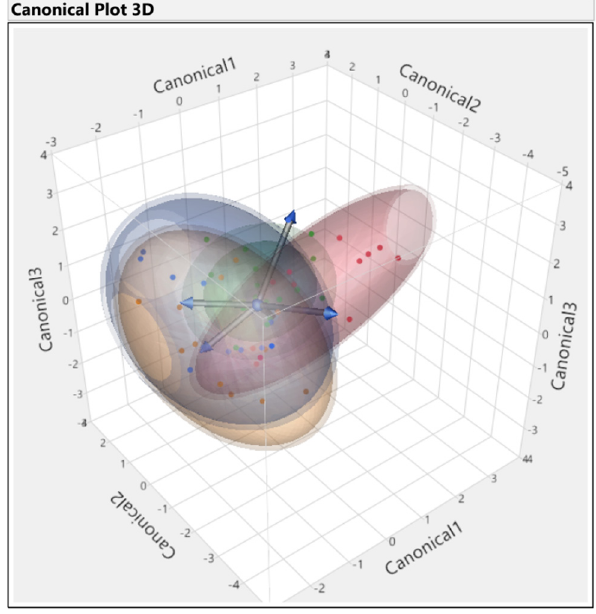
Figure 6. The 3D canonical plot of QDA results in discrimination of four groups based on the three sets of characteristics, including the EL, MDA, proline, CAT, and APX.